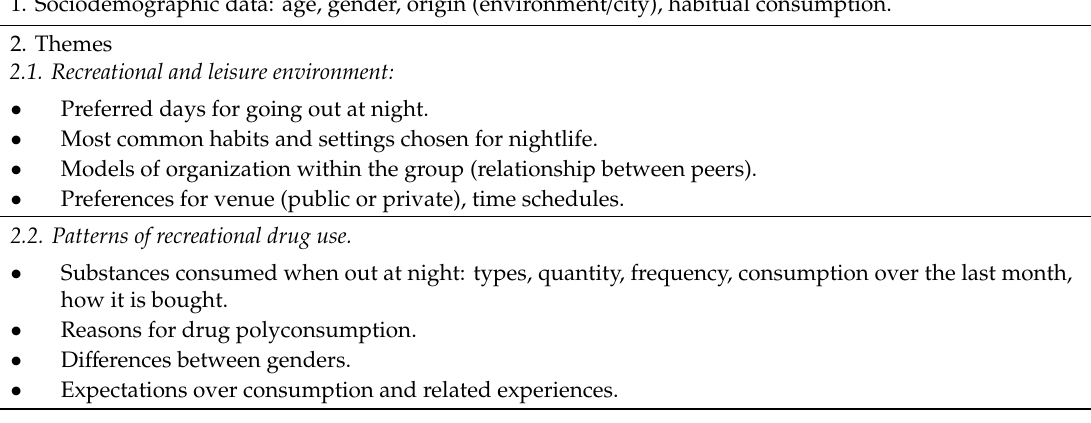
Table 1. Interviews and discussion group (DG)